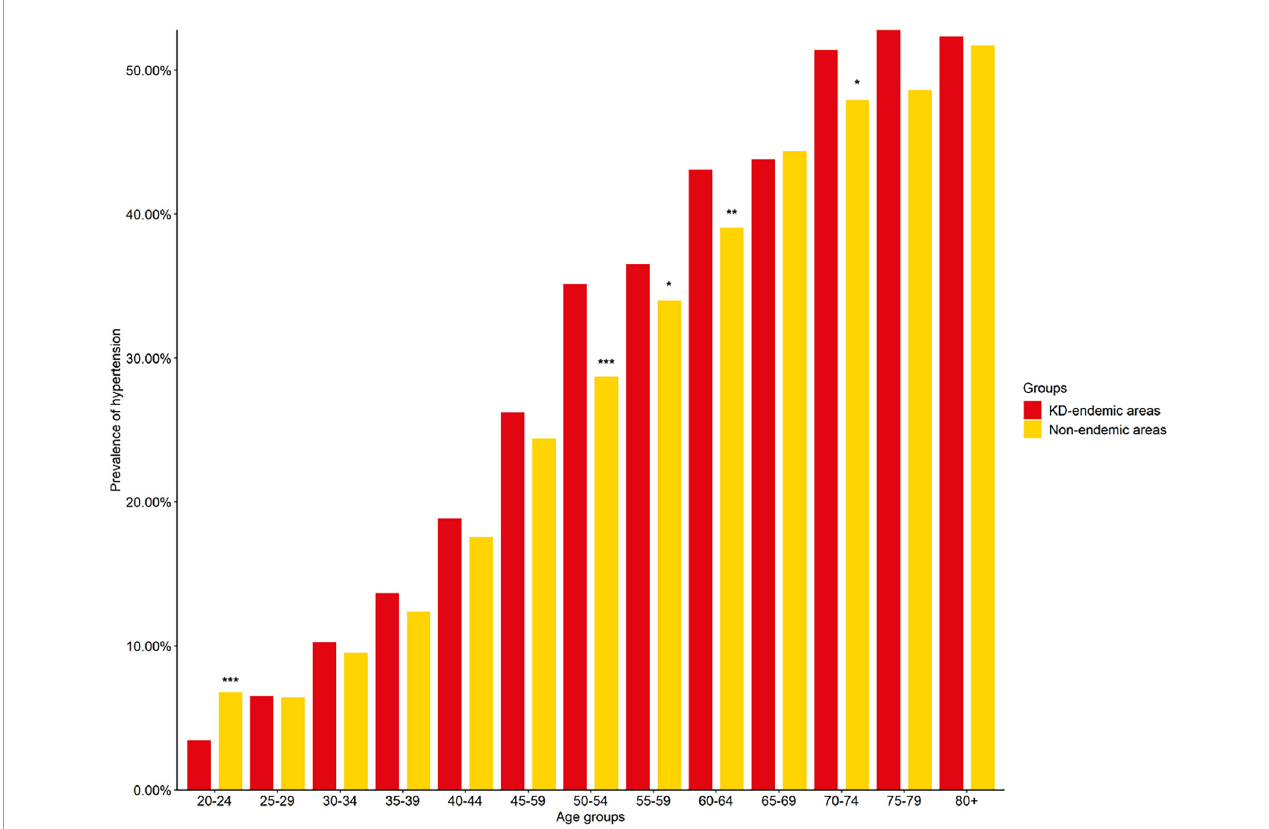
FIGURE2 Hypertension prevalence in KD-endemic and non-endemic areas by age groups. The prevalence was standardized by age and sex based on the 2012 China Statistical Yearbook. KD. Keshan disease; * P < 0.05 compared with KD-endemic areas; ** P < 0.01 compared with KD-endemic areas; *** P < 0.001 compared with KD-endemic